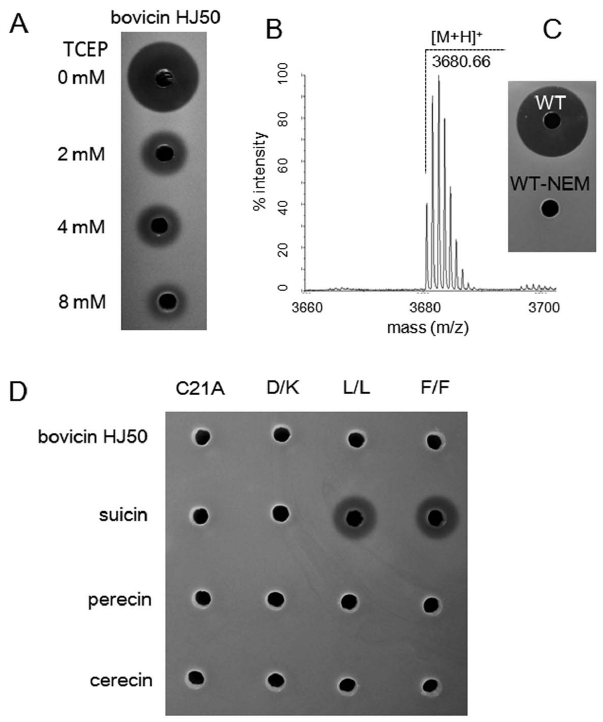
Figure 5. Mutation, substitution and alkylation of disulfide bridge in bovicin HJ50-like lantibiotics. (A) Antimicrobial activity of wild type bovicin HJ50 (25 m L, 5 m g/mL) when treated respectively with 0, 2, 4, 8 mM TCEP. (B) MS analysis of purified NEM-alkylated bovicin HJ50. (C) Antimicrobial activity of wild type bovicin HJ50 (WT) and alkylated bovicin HJ50 (WT-NEM). (D) Antimicrobial activity of disulfide-related mutants. D/K represents substitution of disulfide- forming Cys residues to Asp and Lys, e.g., bovicin HJ50 D/K means bovicin HJ50 mutant C21D/C29K. L/L or F/F is referred as the same condition as D/K. 25 m L peptide samples of 20 m g/mL were applied to each hole.